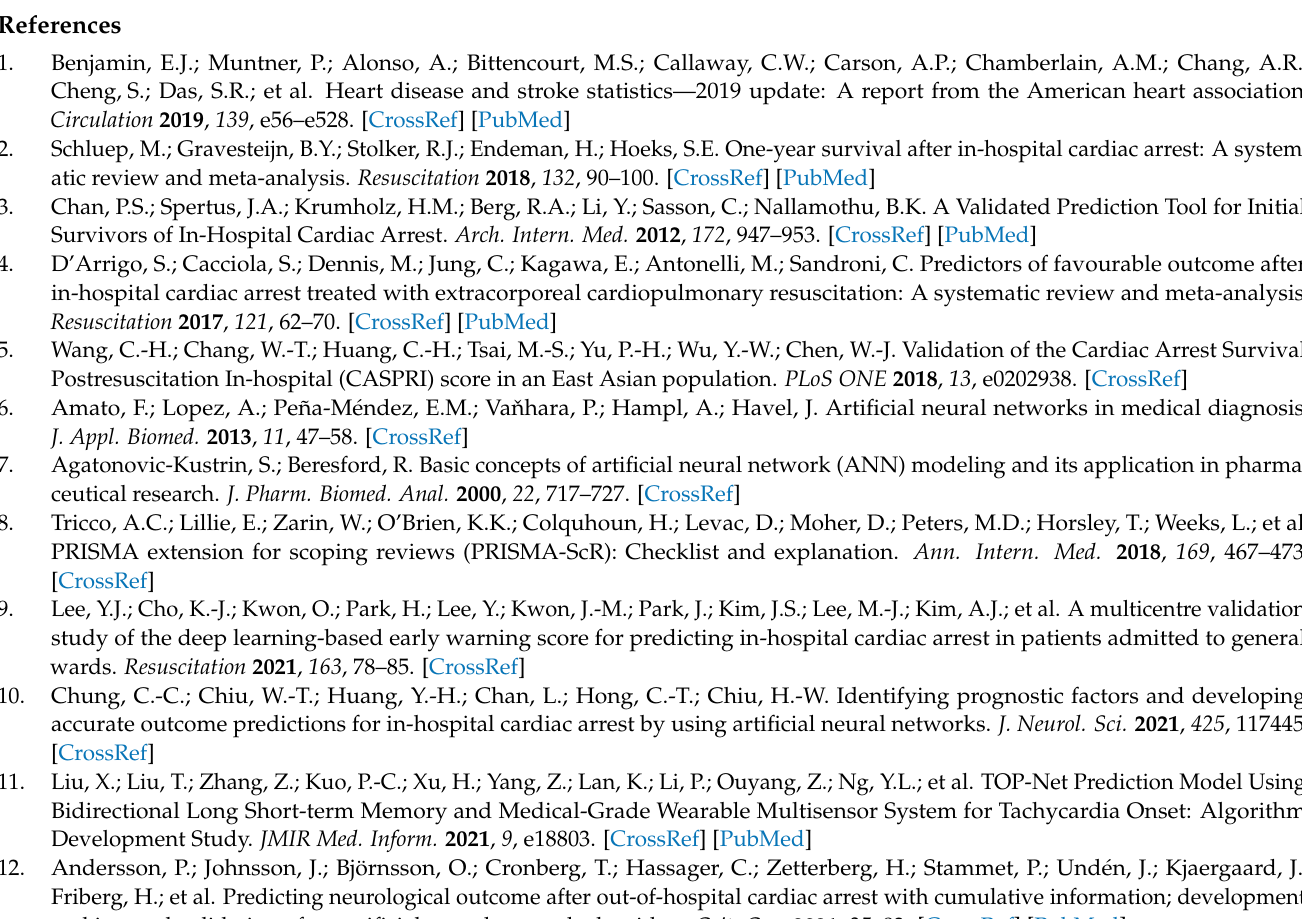
Table S2: Artificial intelligence method and its